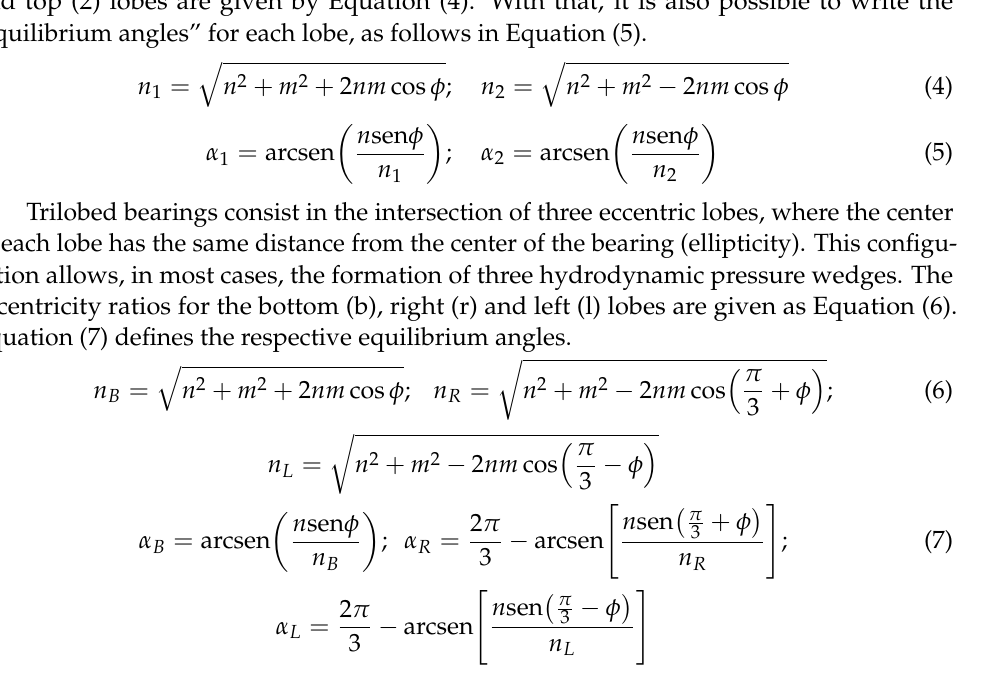
With the eccentricity ratios of each lobe, in both geometries, it is possible to obtain the oil film thickness for each section and, consequently, calculate the pressure distribution of the